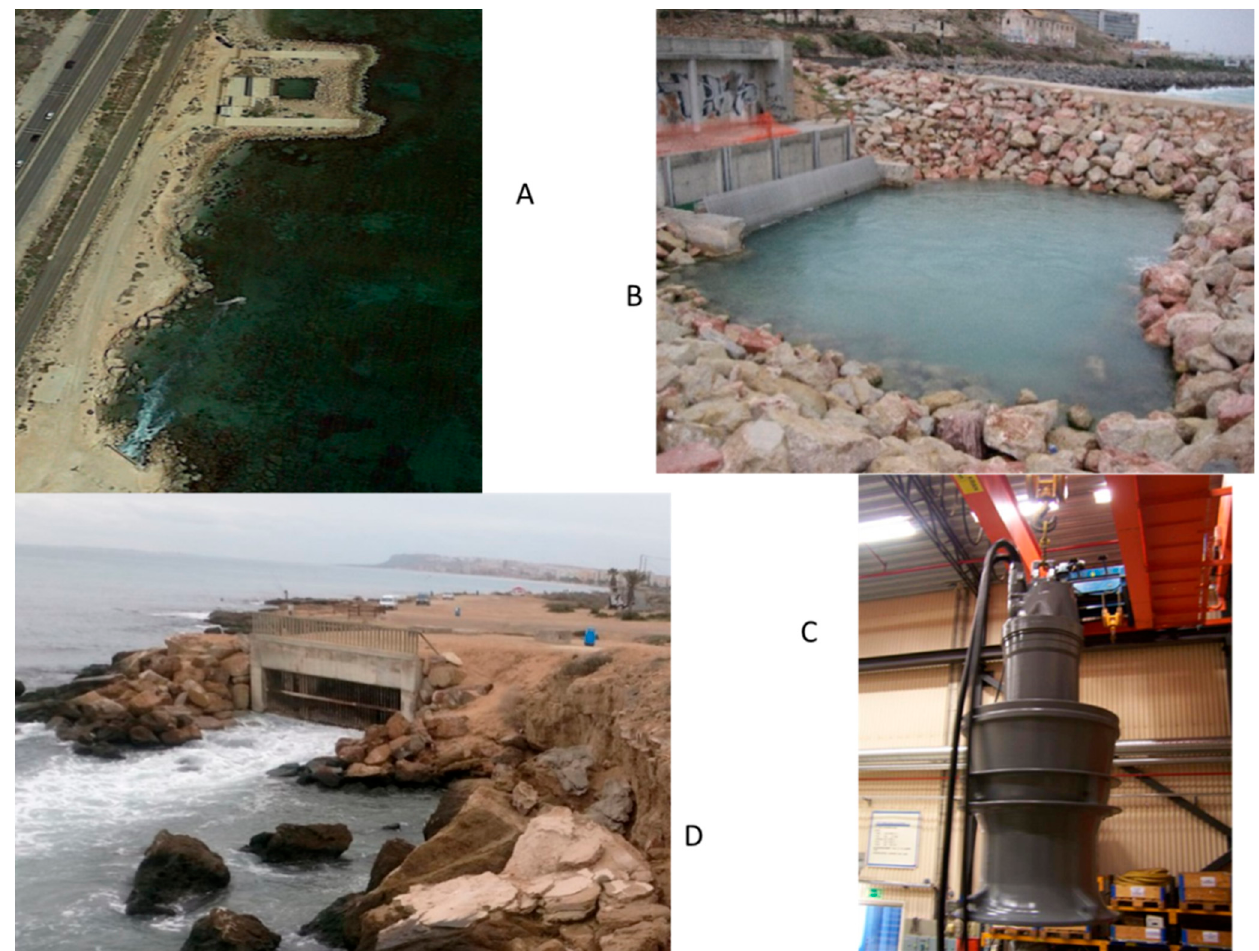
Figure 2. ( A ) Dilution seawater pumping facility (upper part) and discharge point (lower part). ( B ) View of the calming pond and catchment area. ( C ) Seawater pump. ( D ) Discharge of the final effluent in Cala de los Borrachos (Alicante).